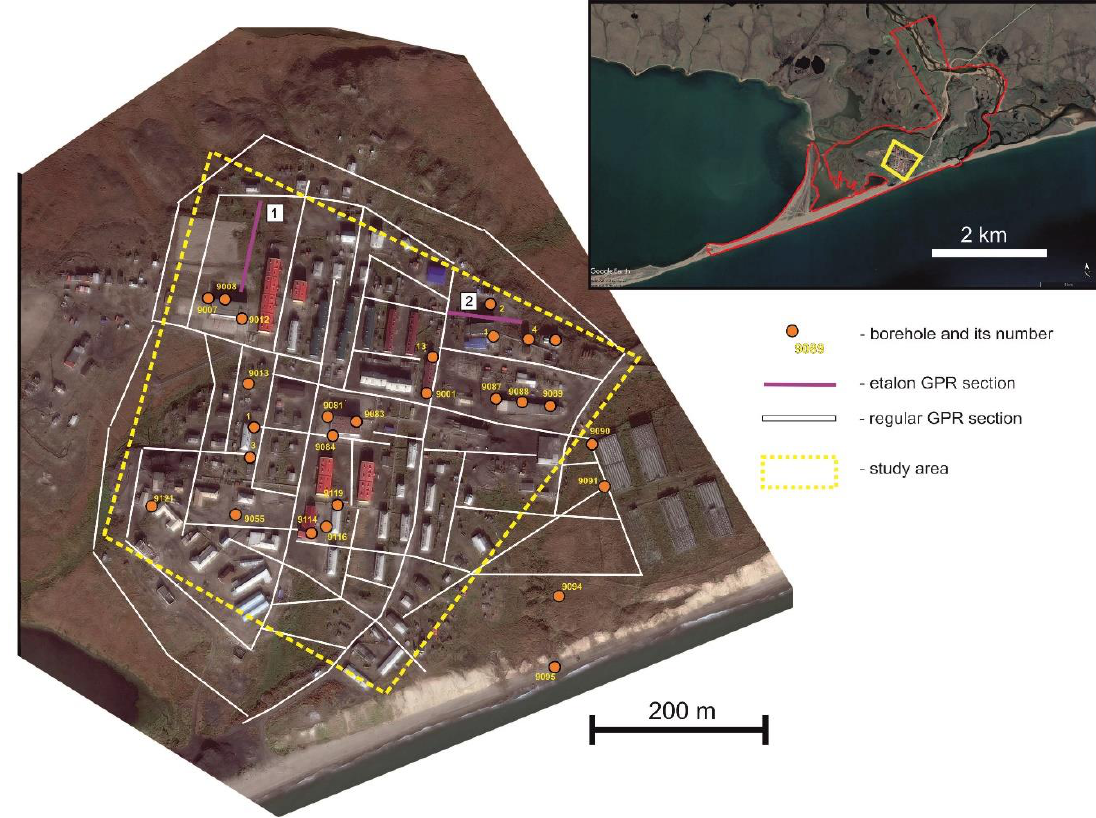
Figure 2. Grid of geo-penetrating radar (GPR) transects and survey boreholes in Lorino.